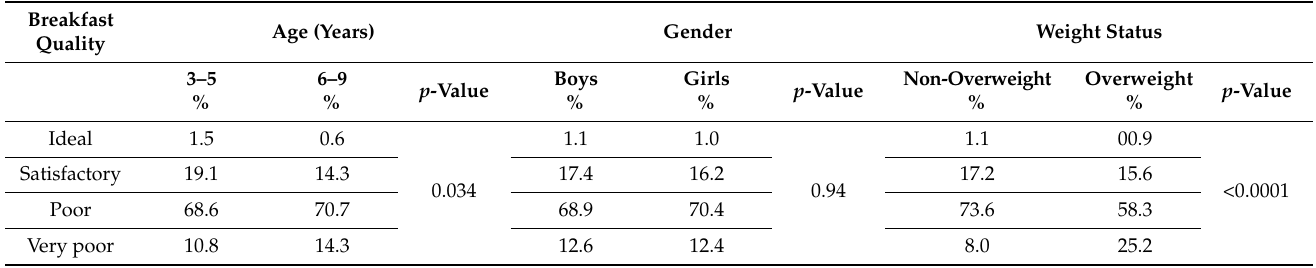
Table 3. Breakfast quality of Tunisian children according to age, gender and weight status.